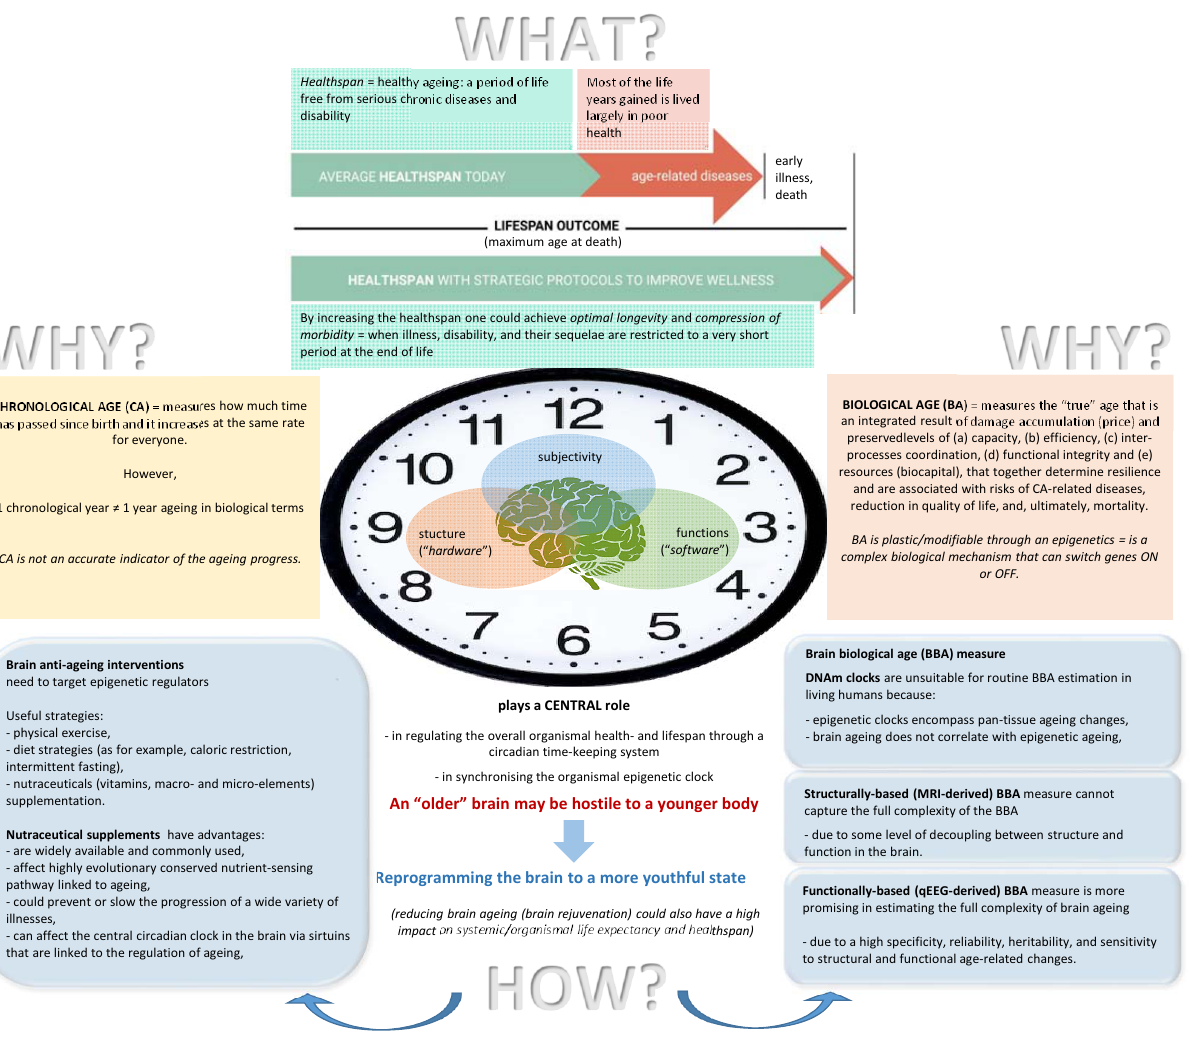
Figure 1. Introduction: What? Why? and